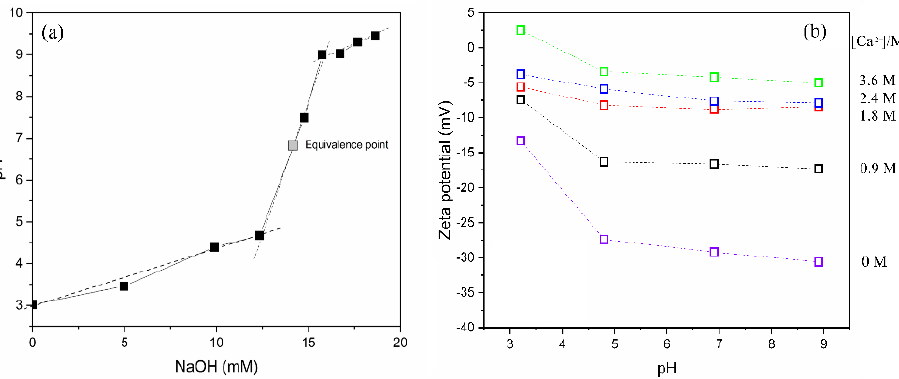
Figure 1. Titration ( a ) and zeta potential ( b ) experiments of pectin extracted from citrus pomelo waste. For pectin solutions having different concentrations of Ca 2+ , the gelation of